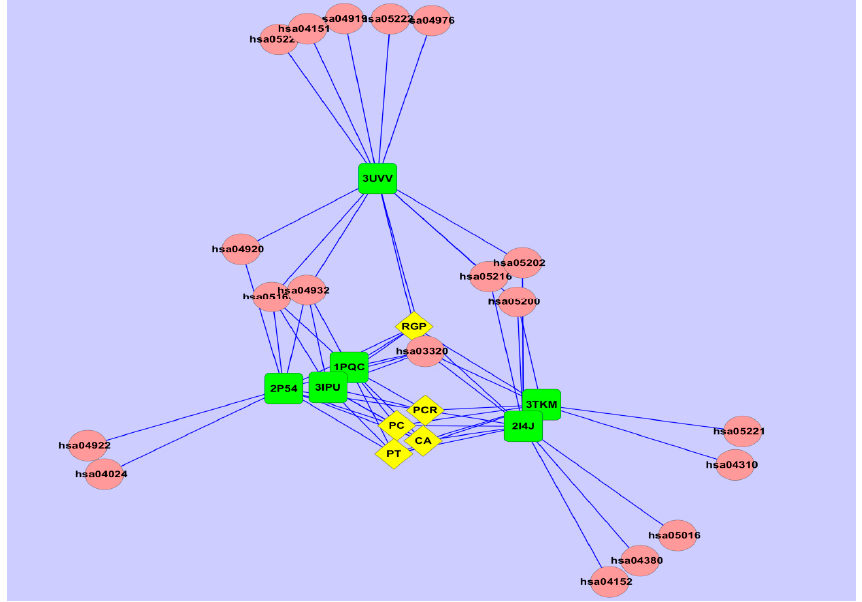
Figure 4. The herb-target-pathway network: the pink round nodes referred to pathways; the yellow rhombic nodes represent herbs; the green quadrate nodes represent targets. Table 6. 19 Kyoto Encyclopedia of Genes and Genomes KEGG pathways associated with 6 predicted targets of WDD.